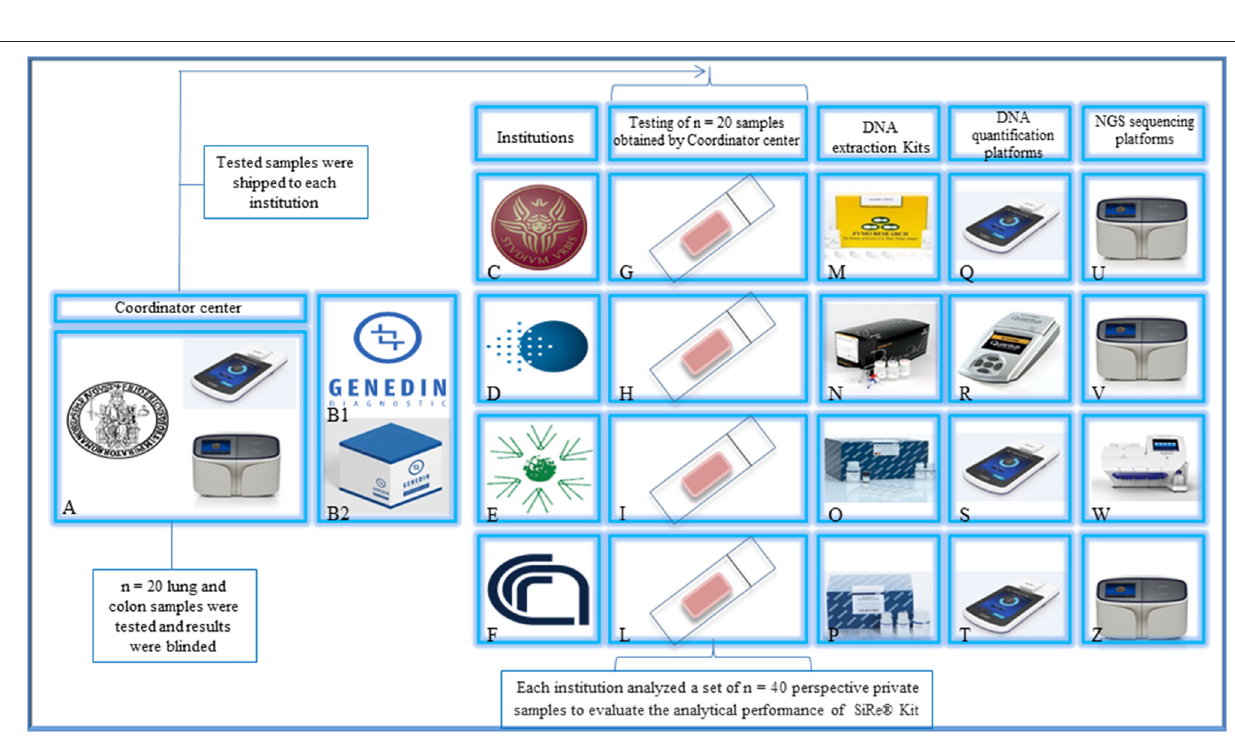
Frontiers in Oncology | www.frontiersin.org